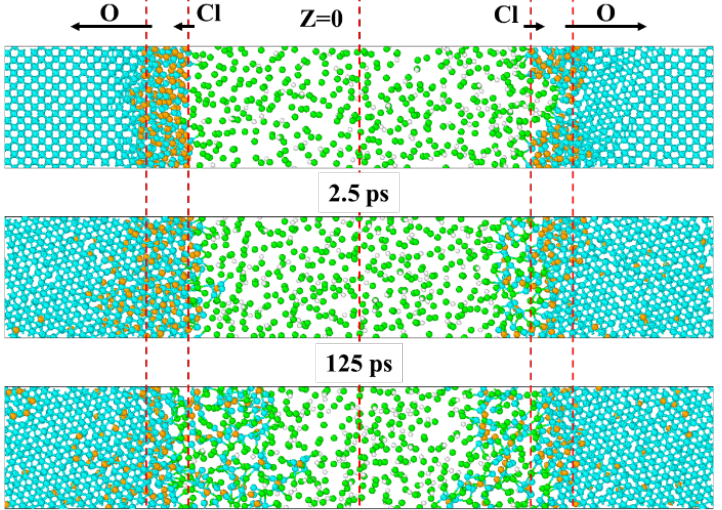
Figure 4. Temporal variations of model B. (Green is chlorine, white is hydrogen, aqua is iron and yellow is oxygen.)